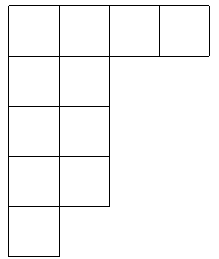
Figure 14. Diagram of partition (cid:21) = (4 ; 2 ; 2 ; 2 ;